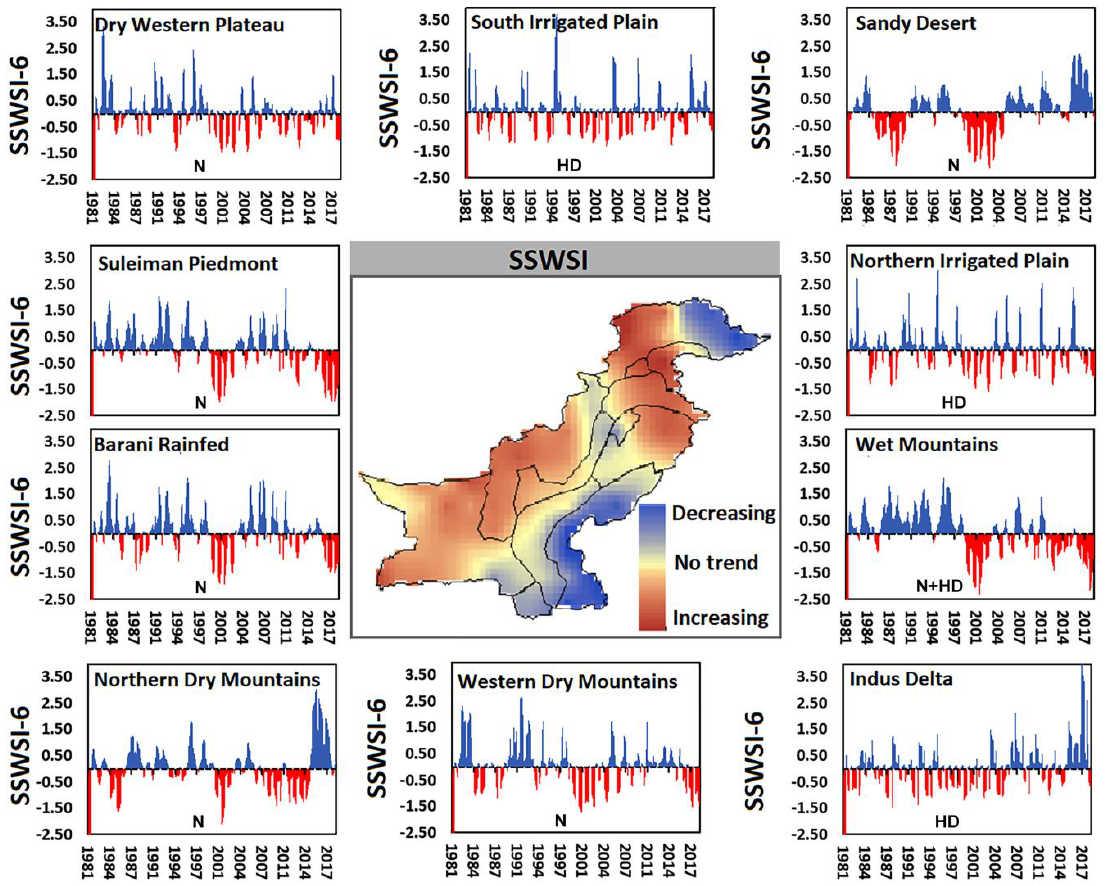
Figure 4. Spatial trend and time series of standardized surface water storage index at a 6-month timescale (SSWSI-6) for 10 different AEZs. Note: N and HD represent natural and human-disturb zones, respectively.